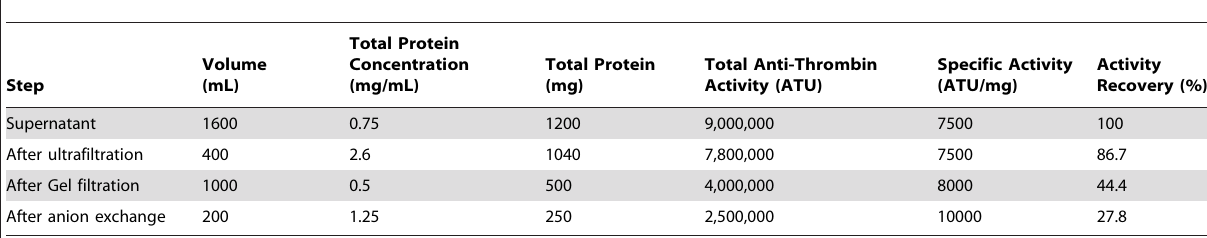
Table 1. Results of 15 N, 13 C-labeled RGD-Hirudin